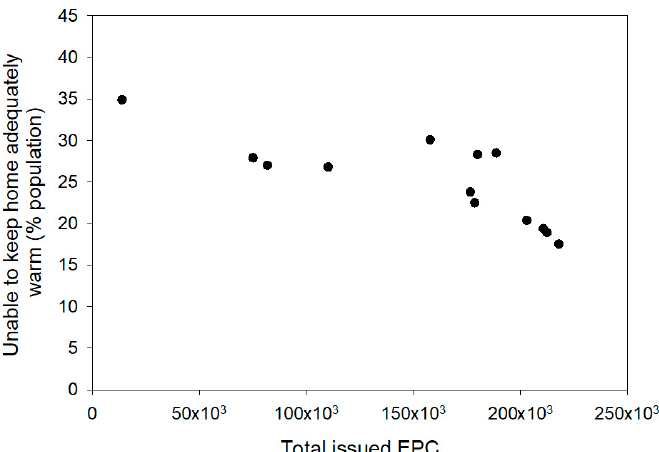
Figure 17. Scatter plot of issued EPC and proportion of inhabitants unable to keep home adequately warm.